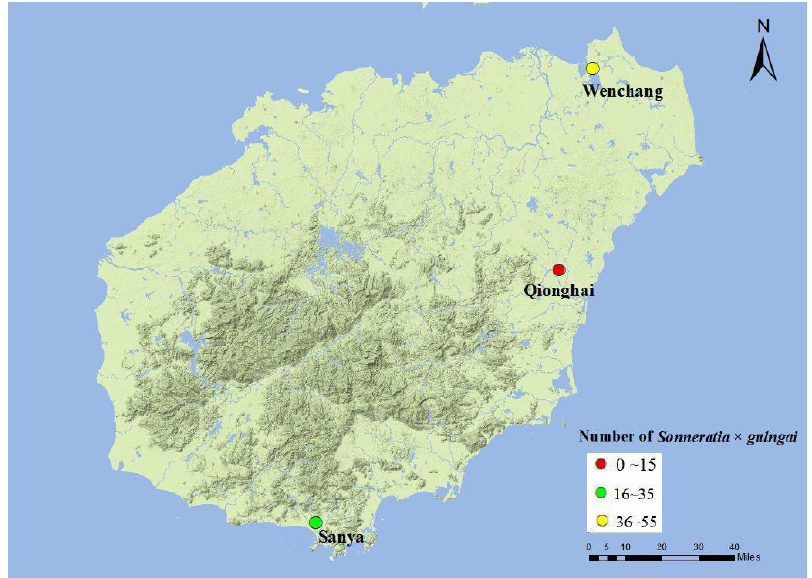
Figure 6. Distribution of Sonneratia × gulngai in Hainan Province, only in Sanya, Qionghai, and Wenchang, with a total number of no more than 100 individuals.